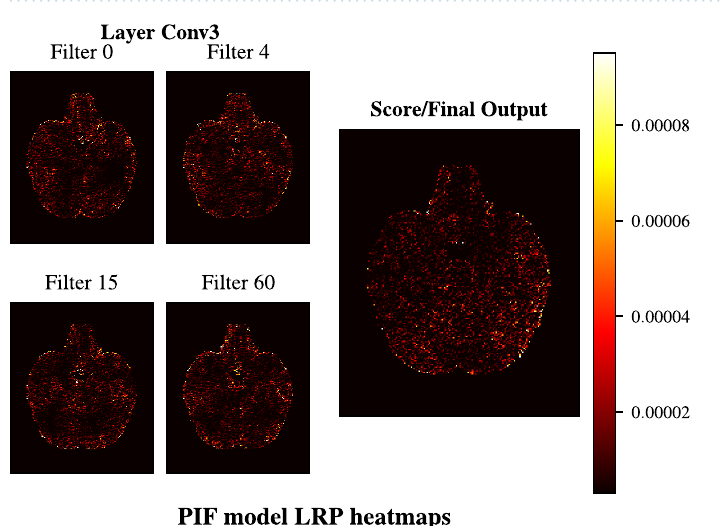
Figure 9. LRP heatmaps of the PIF model trained on the big UK Biobank data set using the PIF layer output to generate patch and filter specific heatmaps. Each patch learns individual filters and therefore patches at the same location (i.e. filter 0 across patches) do not share a specific relation.